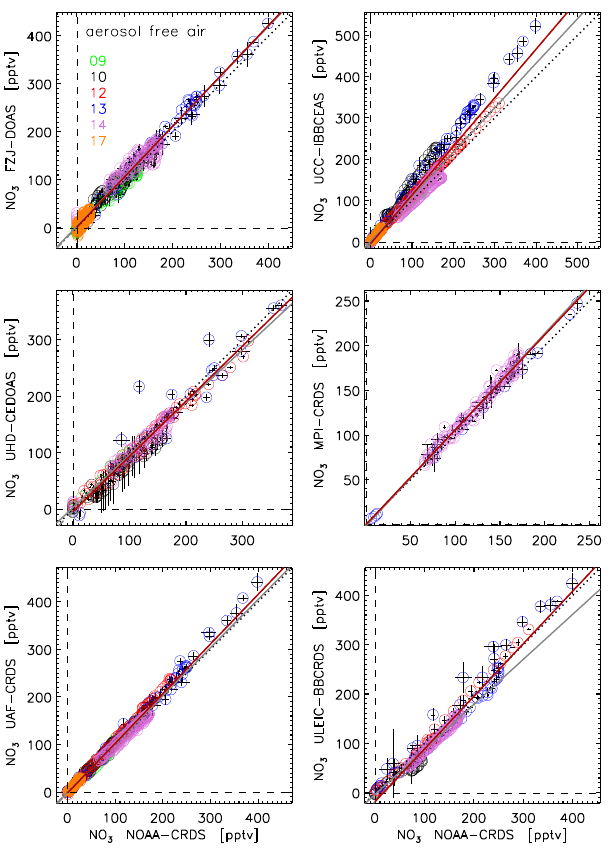
Fig. 6. Correlation of NO 3 measurements versus the reference in- strument NOAA-CRDS in presence of aerosol. See Fig. 5 for details on the regression